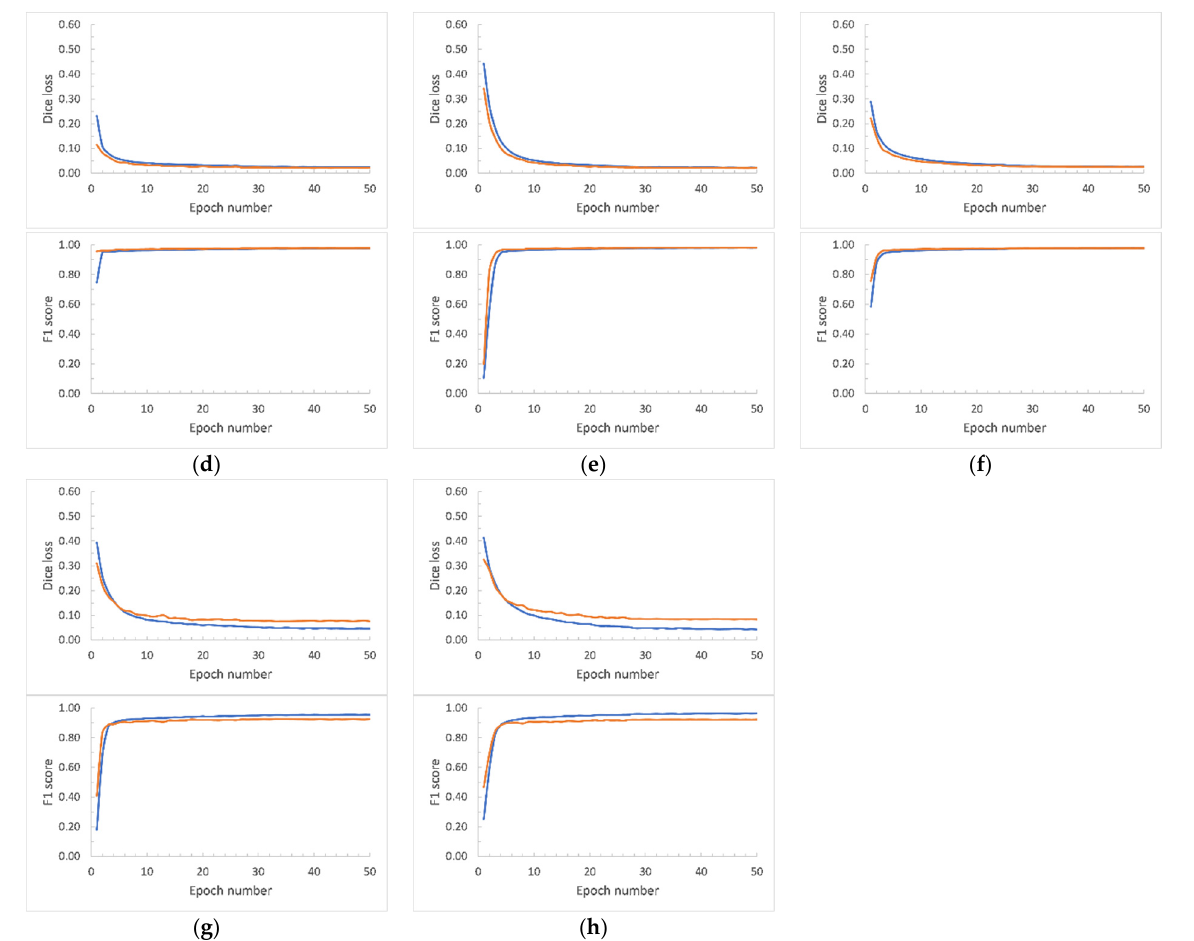
Figure 10. Training (blue line) and validation (orange line) Dice loss curves based on the hand- annotated data from the Eureka Sound Lowlands. Array sizes are shown in pixels. ( a ) Image tile